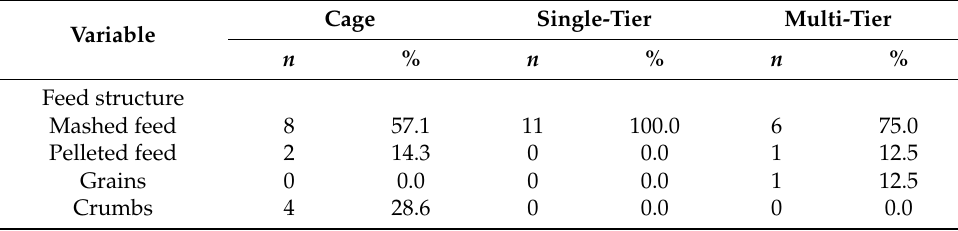
Table 4. Frequency of nutrition and feeding practices for 33 pullet flocks placed between May and November 2017 according to housing system (cage n = 14, single-tier n = 11, multi-tier n = 8) in